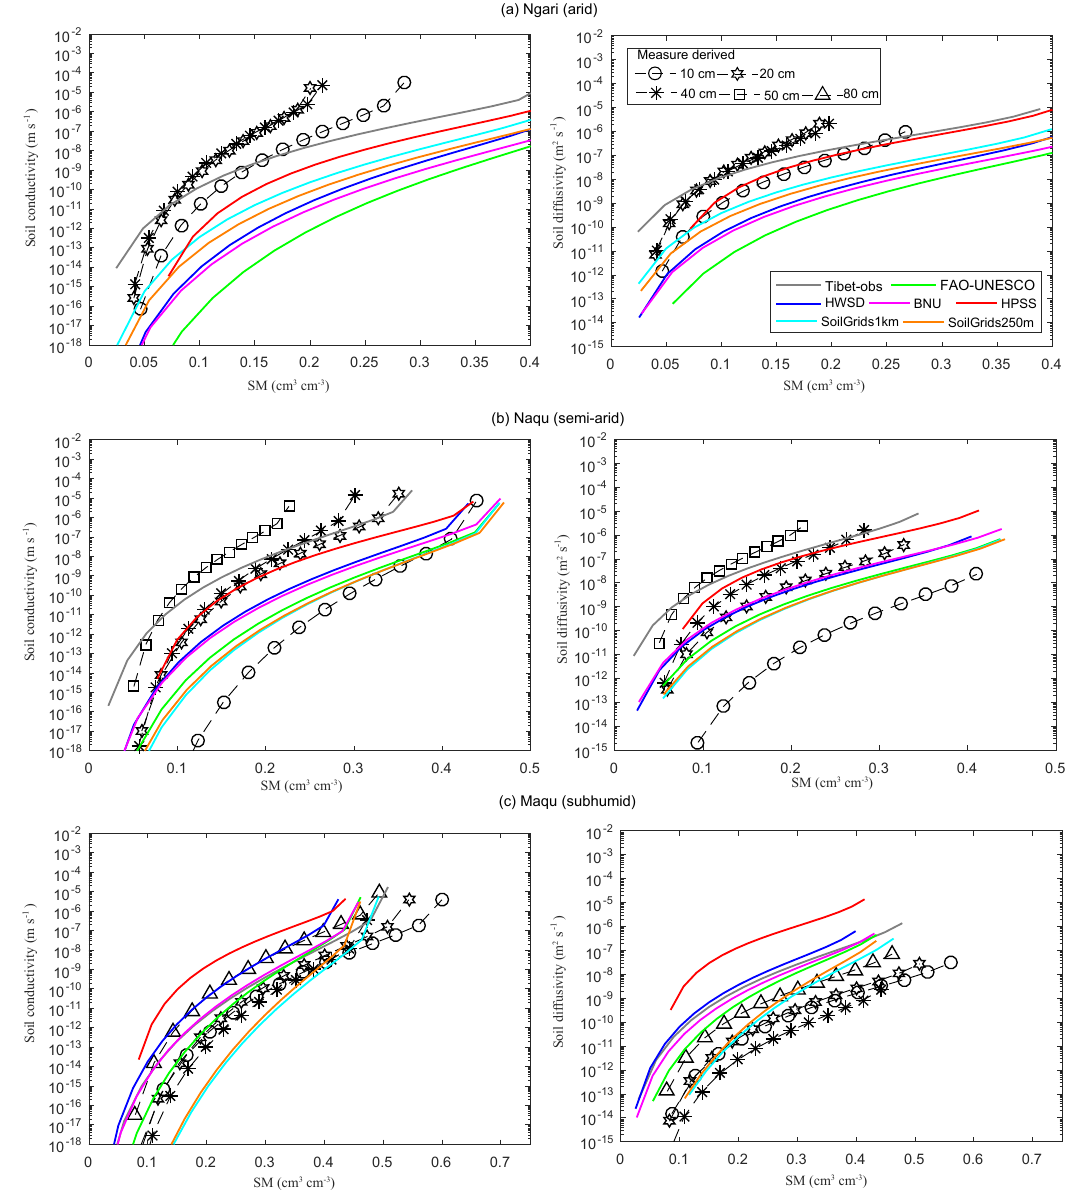
Figure A2. Comparisons of derived soil conductivity ( K ) and soil diffusivity ( D ) by the VG model based on seven soil datasets with those derived from the laboratory measurements. Given the relatively homogenous soil profile derived from existing datasets (see Fig. 12 in the text), the averaged K and D derived from existing datasets over different depths were illustrated. It should be noted that HPSS only provides hydraulic parameters for the VG